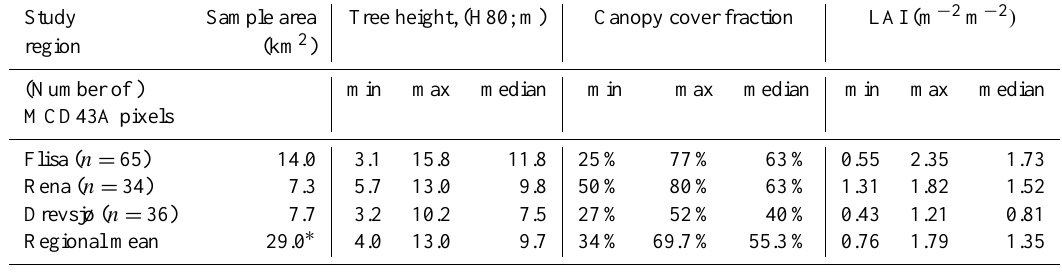
Table 1. Minimum, maximum, and median tree height (H80), canopy cover fraction, and LAI in the sampled evergreen needleleaf forests of each study region (sampled June, 2009). H80 is the 80th percentile of laser scanning first echoes, corresponding to canopy surface height in meters above ground which is correlated to biomass and used as a proxy for tree height.